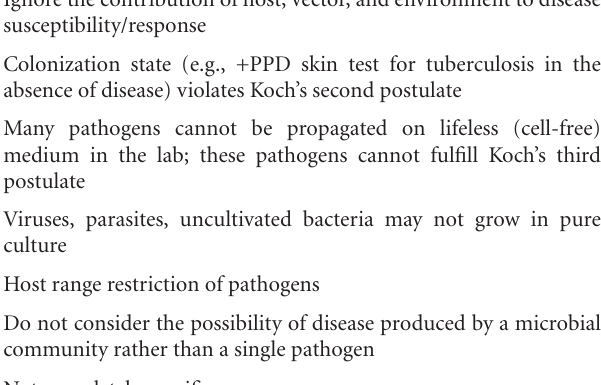
Table 2: Limitations of Koch’s